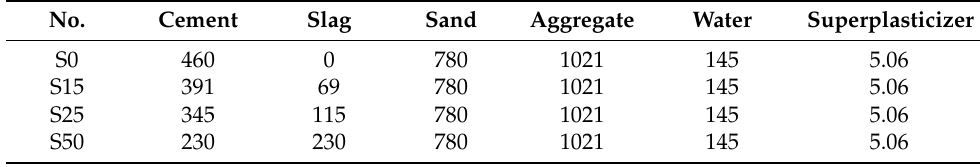
Table 1. Chemical composition of cementitious materials (%).